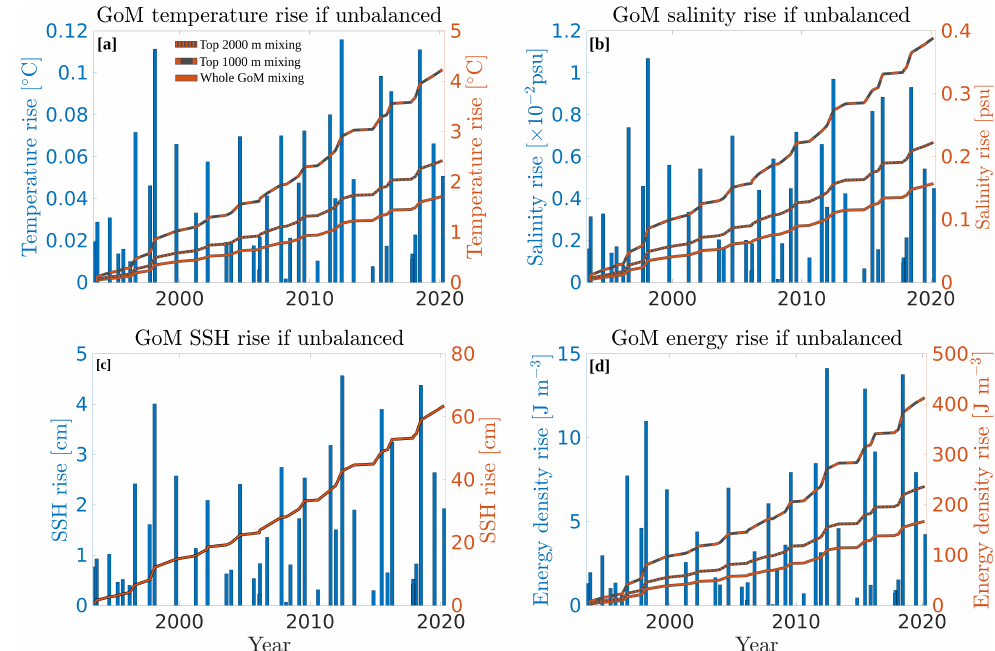
Figure 17. Hypothetical evolution of temperature ( a ), salinity ( b ), sea surface height ( c ), and energy density ( d ) if the heat, salt, and energy inputs of Loop Current rings into the Gulf of Mexico (GoM) were not balanced at all. The bar plots represent the effect of individual eddies while the orange lines represent their cumulative effects over time. The plain line represents the scenario where the excess heat, salt and energy are mixed homogeneously within the entire GoM’s volume. The dashed and dotted lines represent scenarios where the excess of heat, salt and energy are mixed within the top 2000 and 1000 m,